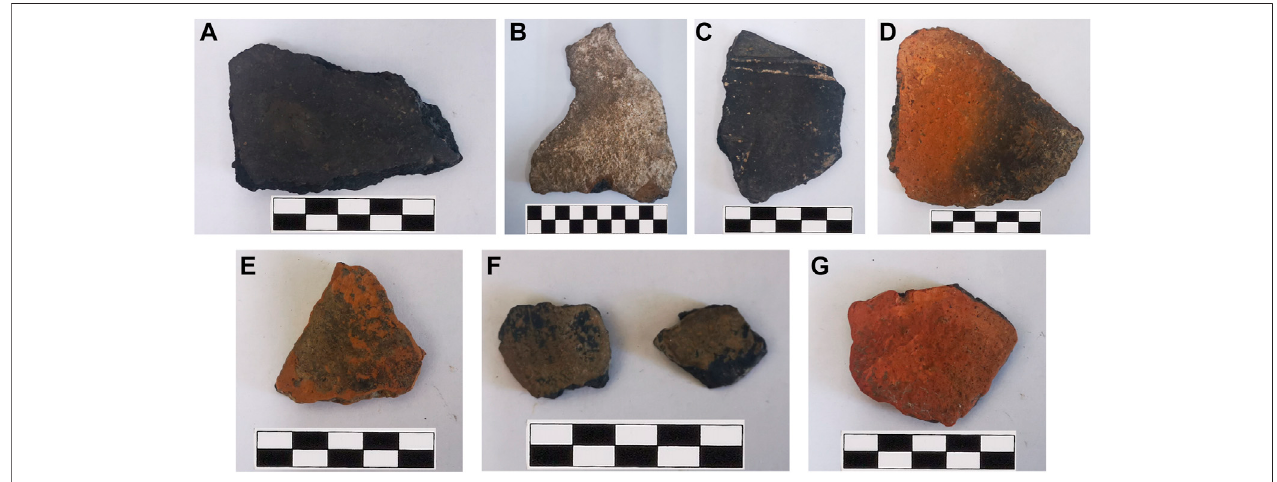
FIGURE 1 | Images of the analyzed ceramic fragments: (A – G) – samples 1 –